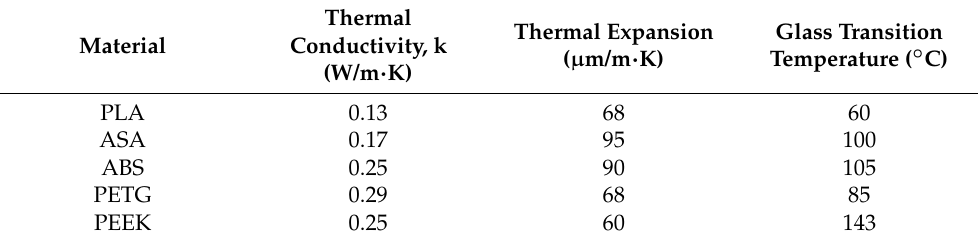
Table 3. Comparison of thermal conductivity of thermoplastic used in 3D printers.